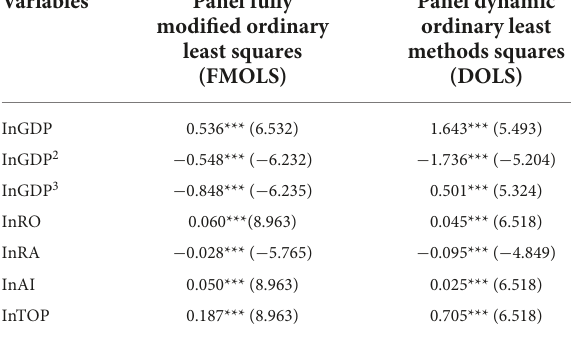
TABLE 5 The result of estimated parameters by FMOLS and DOLS methods, InCO2 = f (InGDP, InGDP2, InGDP3, InRO, InRA, InAI, and InTOP).